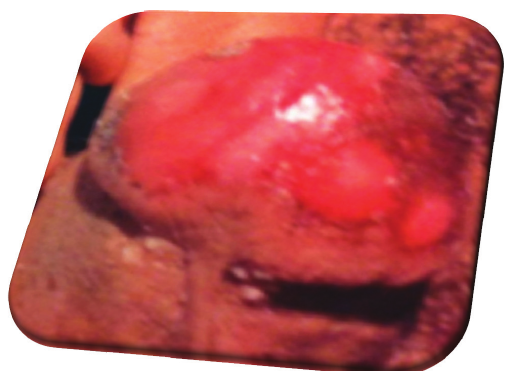
F 2: Erosive lesions on the glans